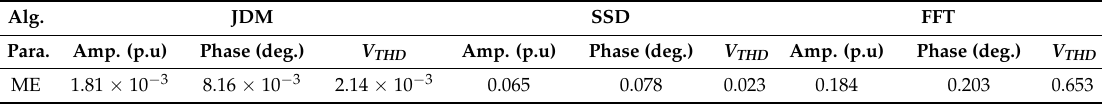
Table 5. Mean errors (MEs) of JDM and SSD on detecting the harmonic parameters of 500 MPDs. Alg. JDM SSD FFT Para. Amp. (p.u) Phase (deg.) V THD Amp. (p.u) Phase (deg.) V THD Amp. (p.u) Phase (deg.) V THD ME 1.81 × 10 − 3 8.16 × 10 − 3 2.14 × 10 − 3 0.065 0.078 0.023 0.184 0.203 0.653 Para.: